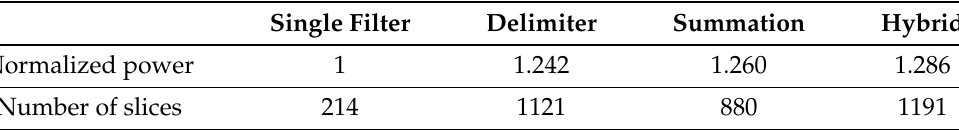
Table 2. Synthesis results and power report of filter